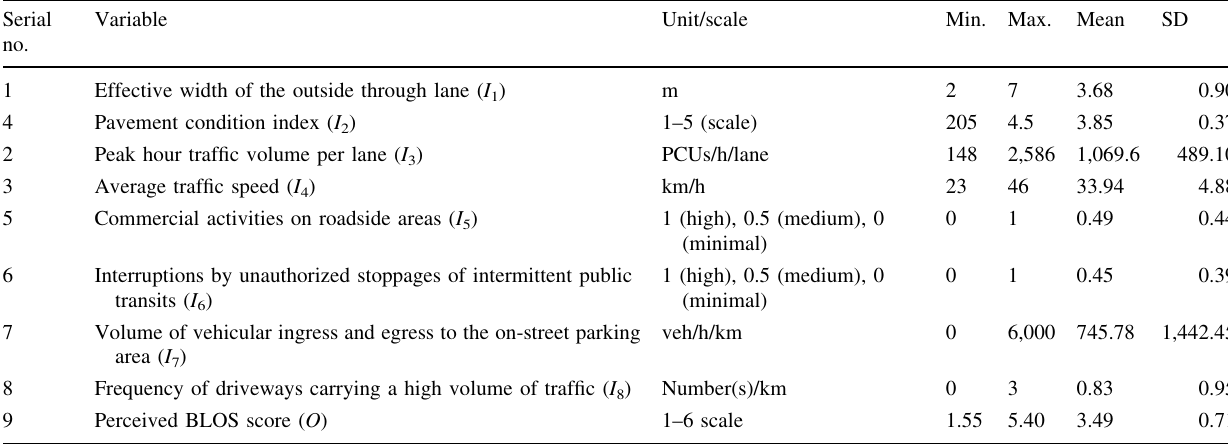
Table 2 Descriptive statistics of data sets used in this research Serial